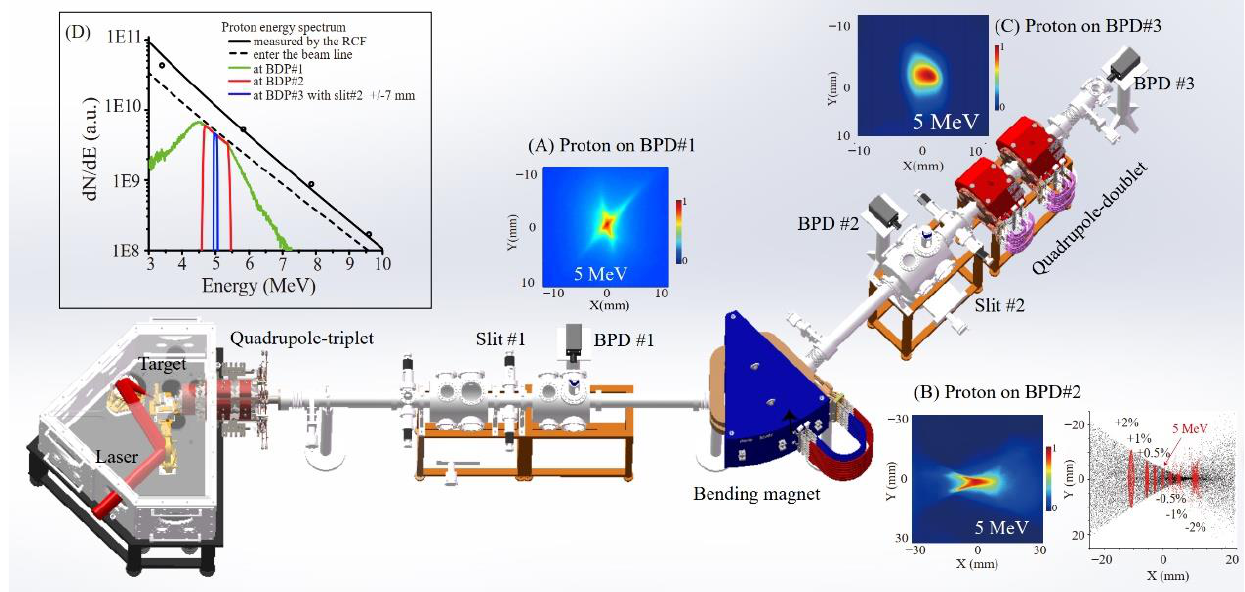
Figure 2. Layout of the acceleration chamber and beamline for CLAPA. The proton beam is accelerated by using a high-contrast laser and micro-thickness foil; it is then focused by a quadrupole triplet lens, analyzed by a bending electromagnet, and refocused by a quadrupole doublet lens with selected energy onto the irradiation platform. The inserted graph ( A ) Experimental result of the 5 MeV proton beam profile at BPD#1 after focusing by the triplet lens. ( B ) Experimental (left) and simulated (right) spatial distributions of the protons at BPD#2. The red dots in the simulated result, from right to left, represent the protons with energy deviated −2%, −1%, −0.5%, 0%, 0.5%, 1% , and 2% from 5 MeV, respectively. ( C ) Proton beam distribution at BPD#3, with a 5 MeV central energy and 1% energy spread. ( D ) Energy spectra of protons at different positions along the beamline. The black solid curve is the original exponentially declining energy spectrum (based on the RCF data shown in Figure 1). The black dashed curve is the actual spectrum entering the beamline within an acceptance angle of ±50 mrad. The green, red, and blue curves are the simulated spectra at the three beam position detectors BPD#1, BPD#2, BPD#3, respectively. The initial beam with a very broad energy spectrum is gradually confined to a 1% energy spread.